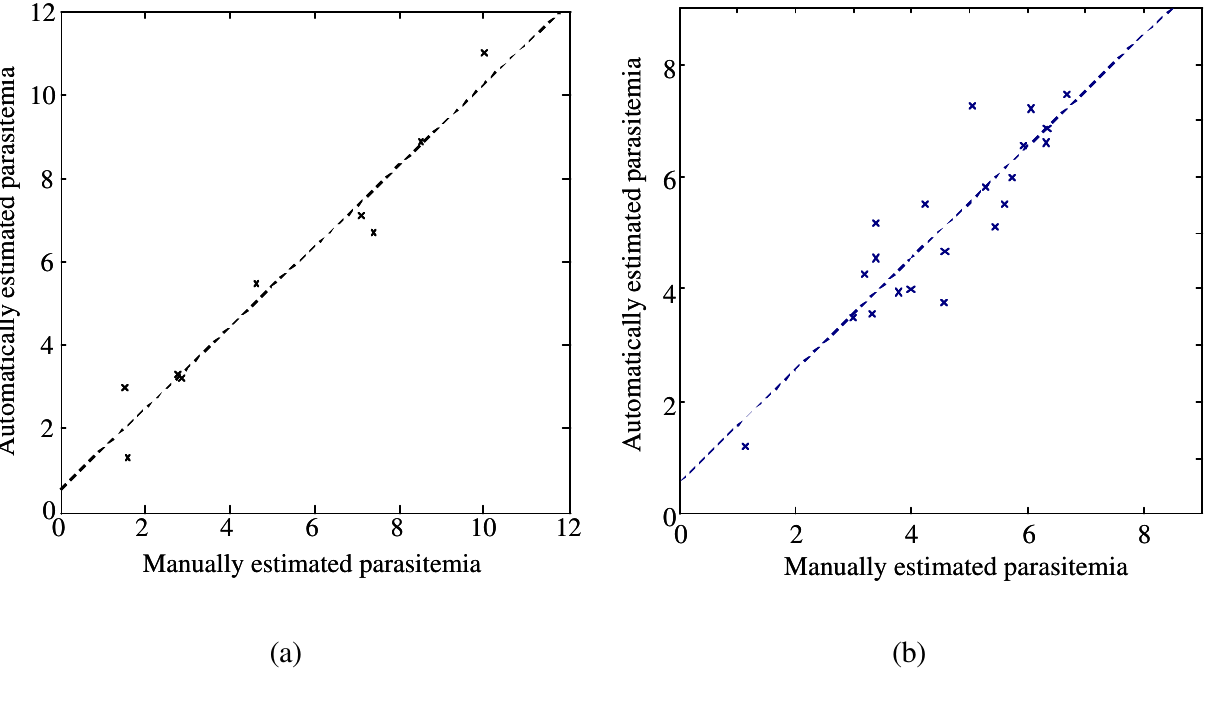
Figure 4 Regression plot of manual versus automated parasitemia estimation . (a) Plasmodium falciparum , (b) Plasmodium yoelii